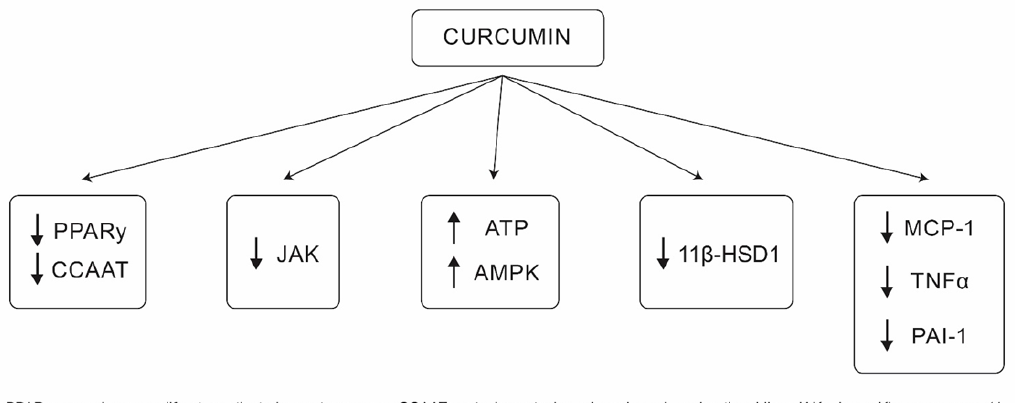
Figure 2. Curcumin mechanisms of action .